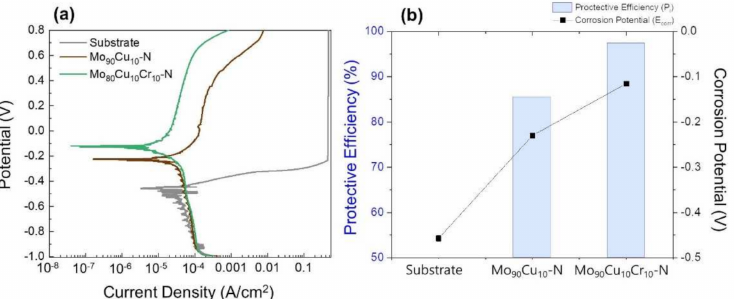
Figure 8. ( a ) Potentiodynamic polarization curves and ( b ) corrosion potential and protective